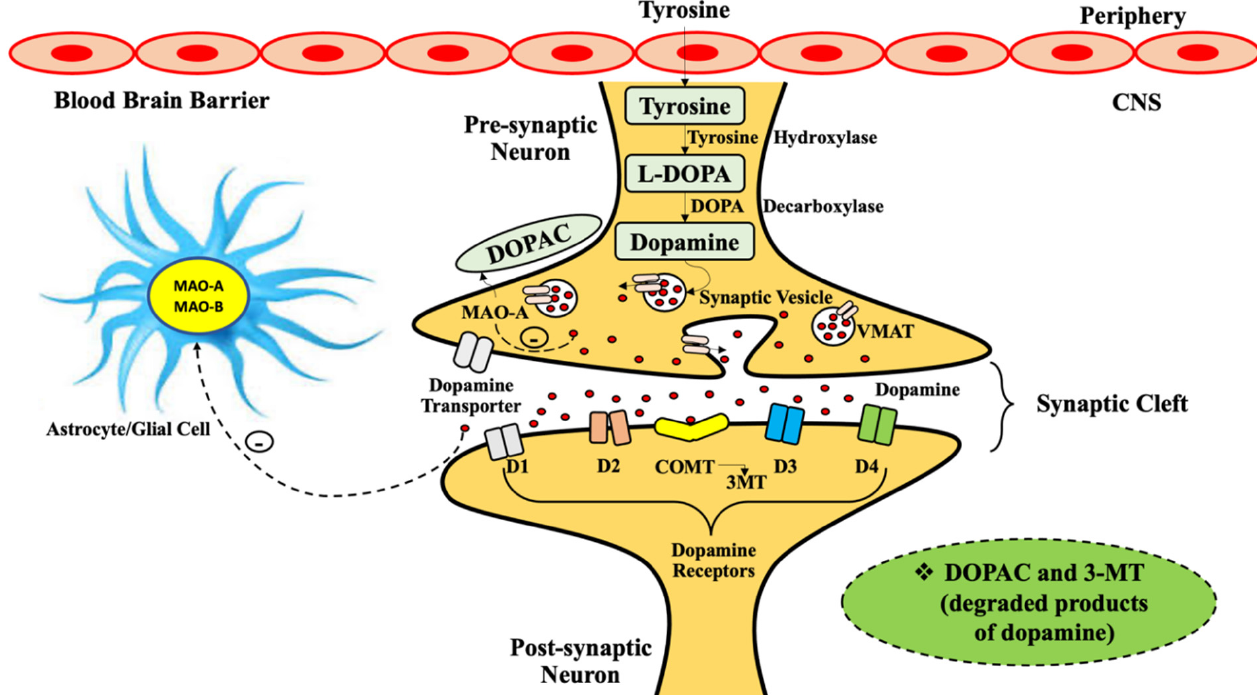
Figure 1. The dopamine synthesis initiates from tyrosine, which crosses the blood–brain barrier (BBB) and transforms into l-dihydroxyphenylalanine (L-DOPA) via tyrosine hydroxylase (TH). Consecutive decarboxylation by DOPA decarboxylase (DDC) transforms L-DOPA into dopamine neurotransmitter inside neurons. Dopamine is entrapped in synaptic vesicles by VMAT-2 (vesicular monoamine transporter 2) or degraded by monoamine oxidase-A (MAO-A) enzyme present in neurons, and by astrocyte and glial MAO-A and MAO-B enzyme into respective degraded products. Dopamine. D1, D2, D3, D4 are dopamine receptors. Legend: L-DOPA—l-dihydroxyphenyl alanine; VMAT—vesicular monoamine transporter; COMT—catechol-O-methyltransferase; 3-MT—3-methoxytyramine; DOPAC-3,4—dihydroxyphenyl acetic acid; CNS—central nervous system.